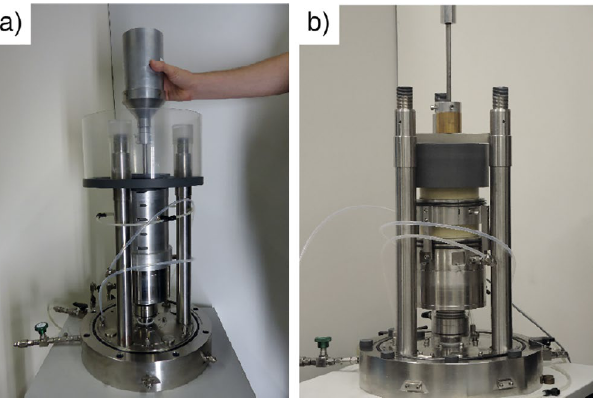
Figure 5. Preparation of the sample by ( a ) dry air pluviation method (AP) and ( b ) moist tamping technique (MT) 34